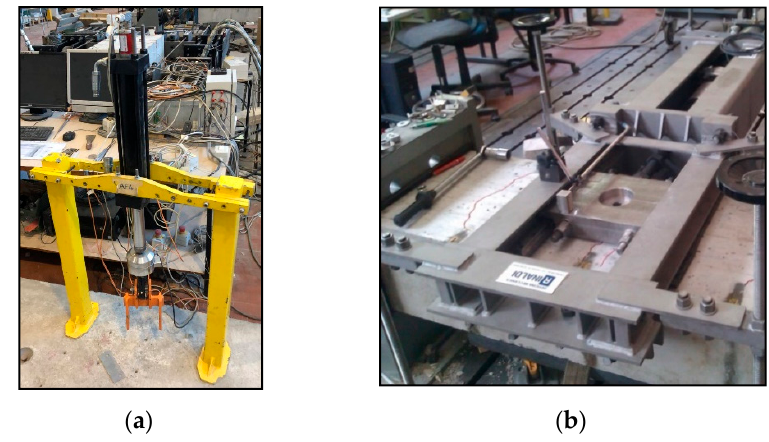
Figure 6. ( a ) Apparatus for tension; ( b ) apparatus for shear.